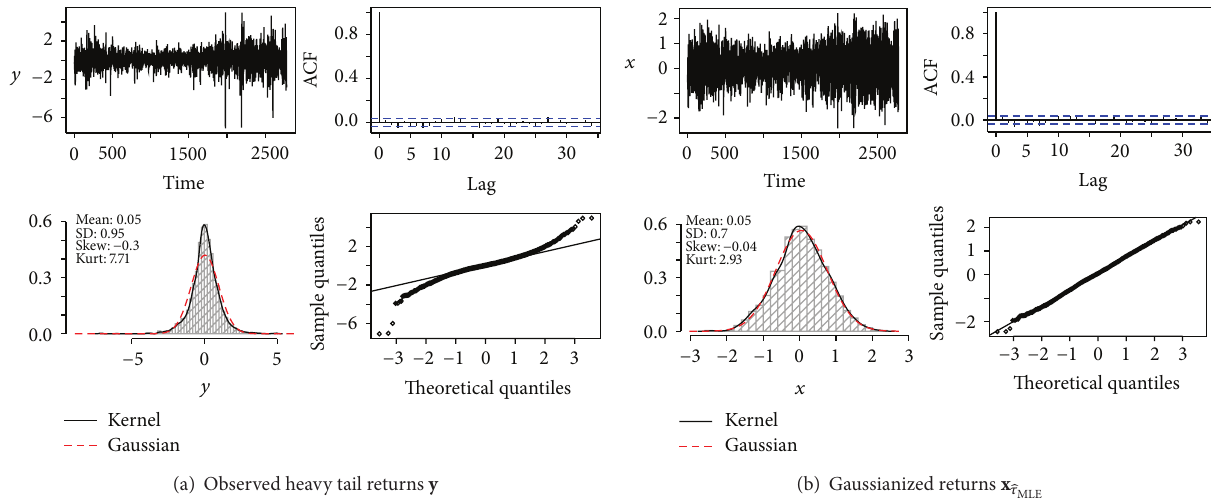
Figure 7: Lambert W Gaussianization of S&P 500 log-returns: ̂𝜏 = (0.05, 0.70, 0.17) . In (a) and (b): data (top left); autocorrelation function (ACF) (top right); histogram, Gaussian fit, and KDE (bottom left); Normal QQ plot (bottom